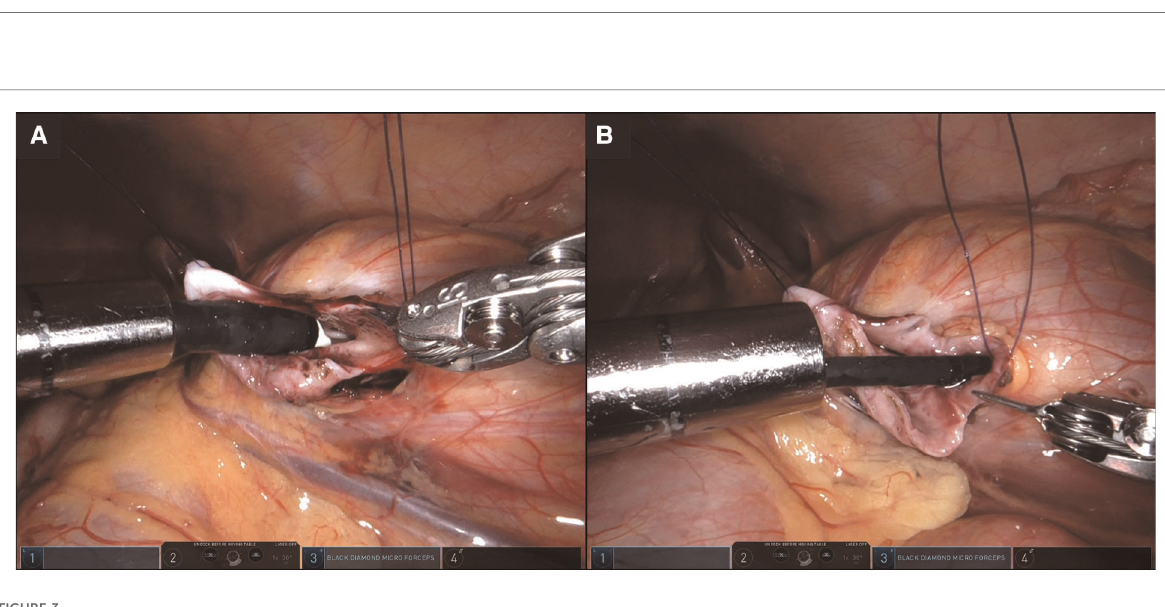
FIGURE 3 ( A ) Easy access by a Fr16 fl exible cystoscope to the upper and mid-pole calyces for examination. ( B ) The lower pole calyx with narrow infundibulum allowed the passage of a Fr8.7/9.3 fl exible ureteroscope after failed attempts by the fl exible cystoscope. ( A,B ) Tip of the epigastric port close to